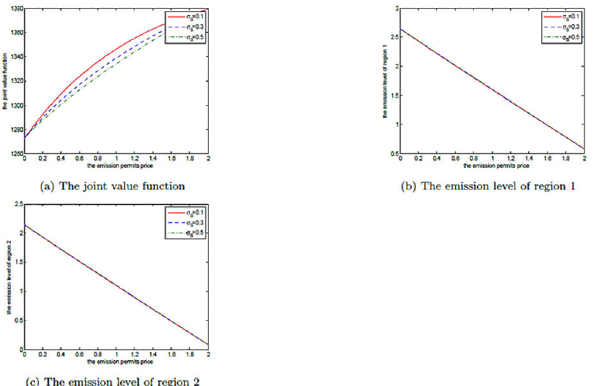
Fig 12. The effects of σ S on the cooperative